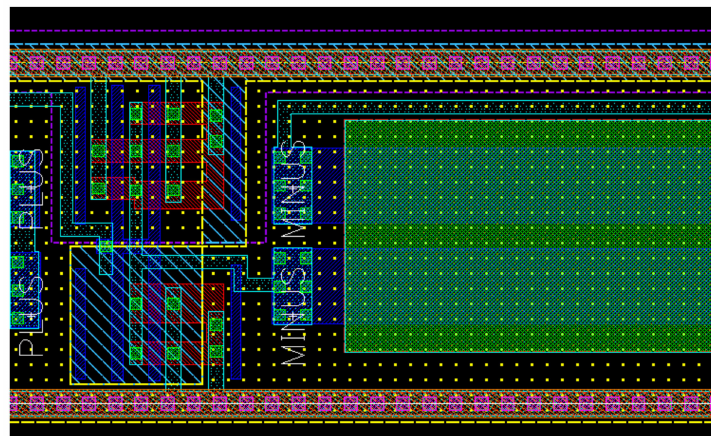
Figure 6. The left part of the layout of the proposed Abacus-R time-delay cell.